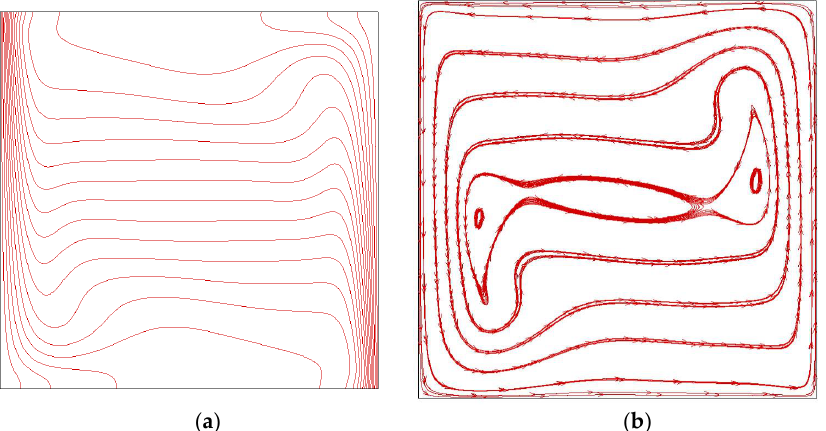
Figure 3. Natural convection in a side-heated cavity for Pr = 0.7 at Ra = 10 6 obtained with the lattice Boltzmann (LB) model: ( a ) isotherms and ( b ) streamlines.